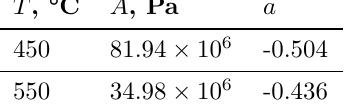
Table 2. Fitted parameters in the fatigue life model for smooth specimens, see Eqn. 14.